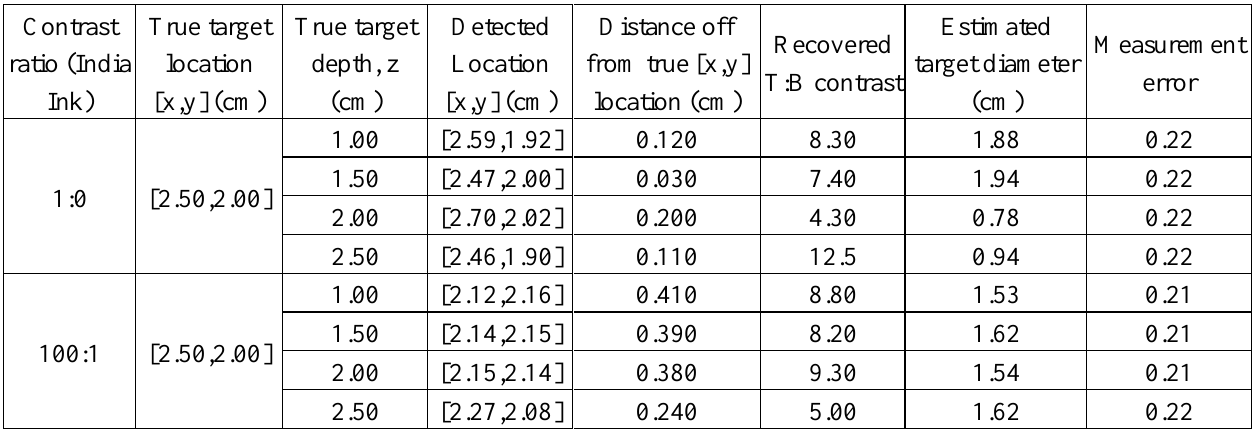
Table 2. Quantitative details of the detected target location, size, recovered T:B contrast and measurement errors for different experimental cases using the Gen-2 imager towards reflectance imaging